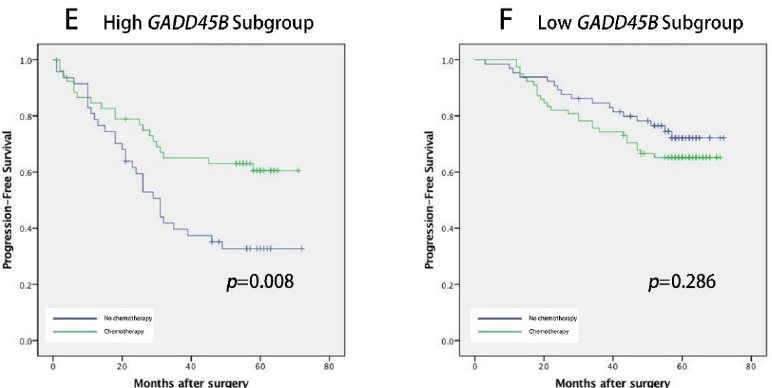
Figure 3. Prognostic power of GADD45B in stage II CRC cohort CRC cohort Kaplan-Meier analyses of overall survival and progression-free survival in patients with CRC based on the expression of GADD45B . Overall survival and progression-free survival (PFS) accord to GADD45B expression in stage II CRC ( A , B ). The relationship between GADD45B expression and PFS benefits from adjuvant chemotherapy in patients with stage II CRC. There was no significant difference in OS and PFS between the patients who received chemotherapy and the patients who never received the adjuvant therapy after surgery ( C , D ). Treatment with 5 ‐ Fluorouracil ‐ based (5 ‐ FU ‐ based) chemotherapy was associated with a higher rate of PFS in the GADD45B high group ( E ) but not in the GADD45B low group ( F ).